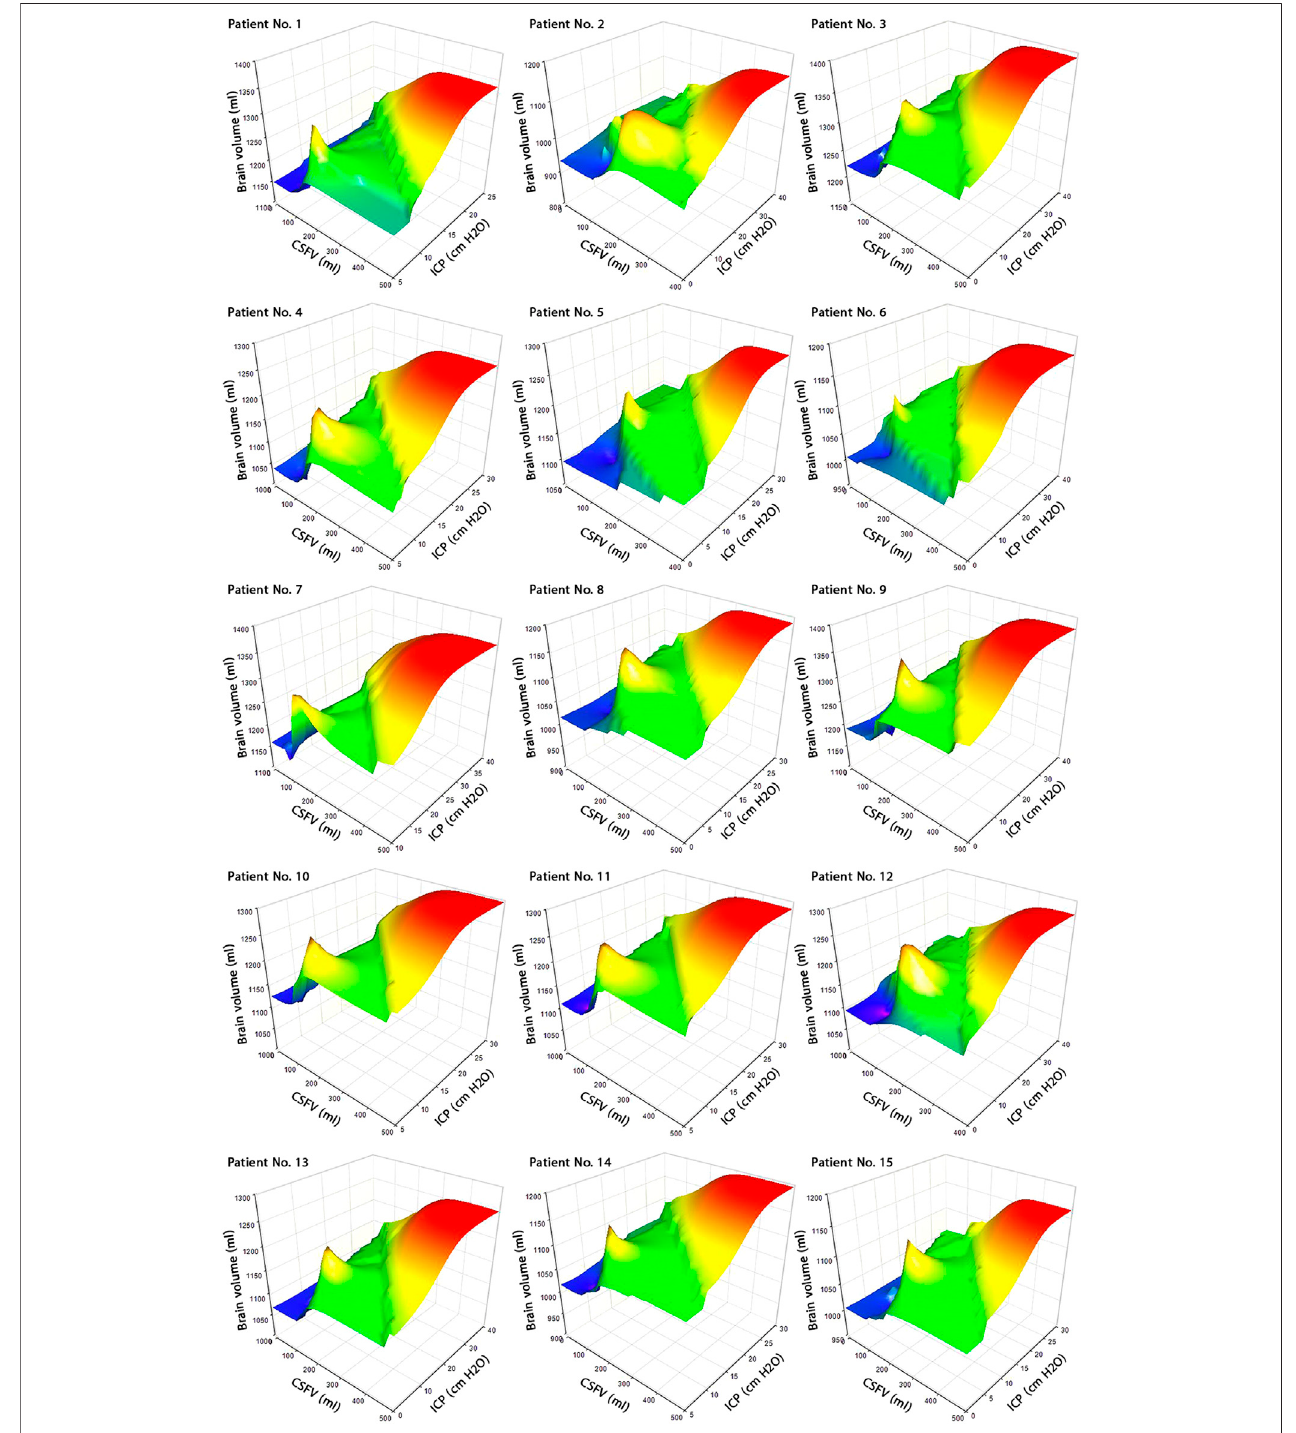
FIGURE4| ConcurrentchangesofCSFV, brainvolume, andICP. 3DgraphsofCSFV – brainvolume – ICP during shunttreatment forall 15patients.Thechangesin CSFV,brainvolume,andICP frompriortoshuntingto18 monthsaftershuntingwerenotuniform,andthesurfacesofgraphsarenotsmooth.Rawdatafor Figure3 are included in Supplementary Tables S1, S2, and S3 . CSFV: cerebrospinal fl uid volume; and ICP: intracranial pressure.